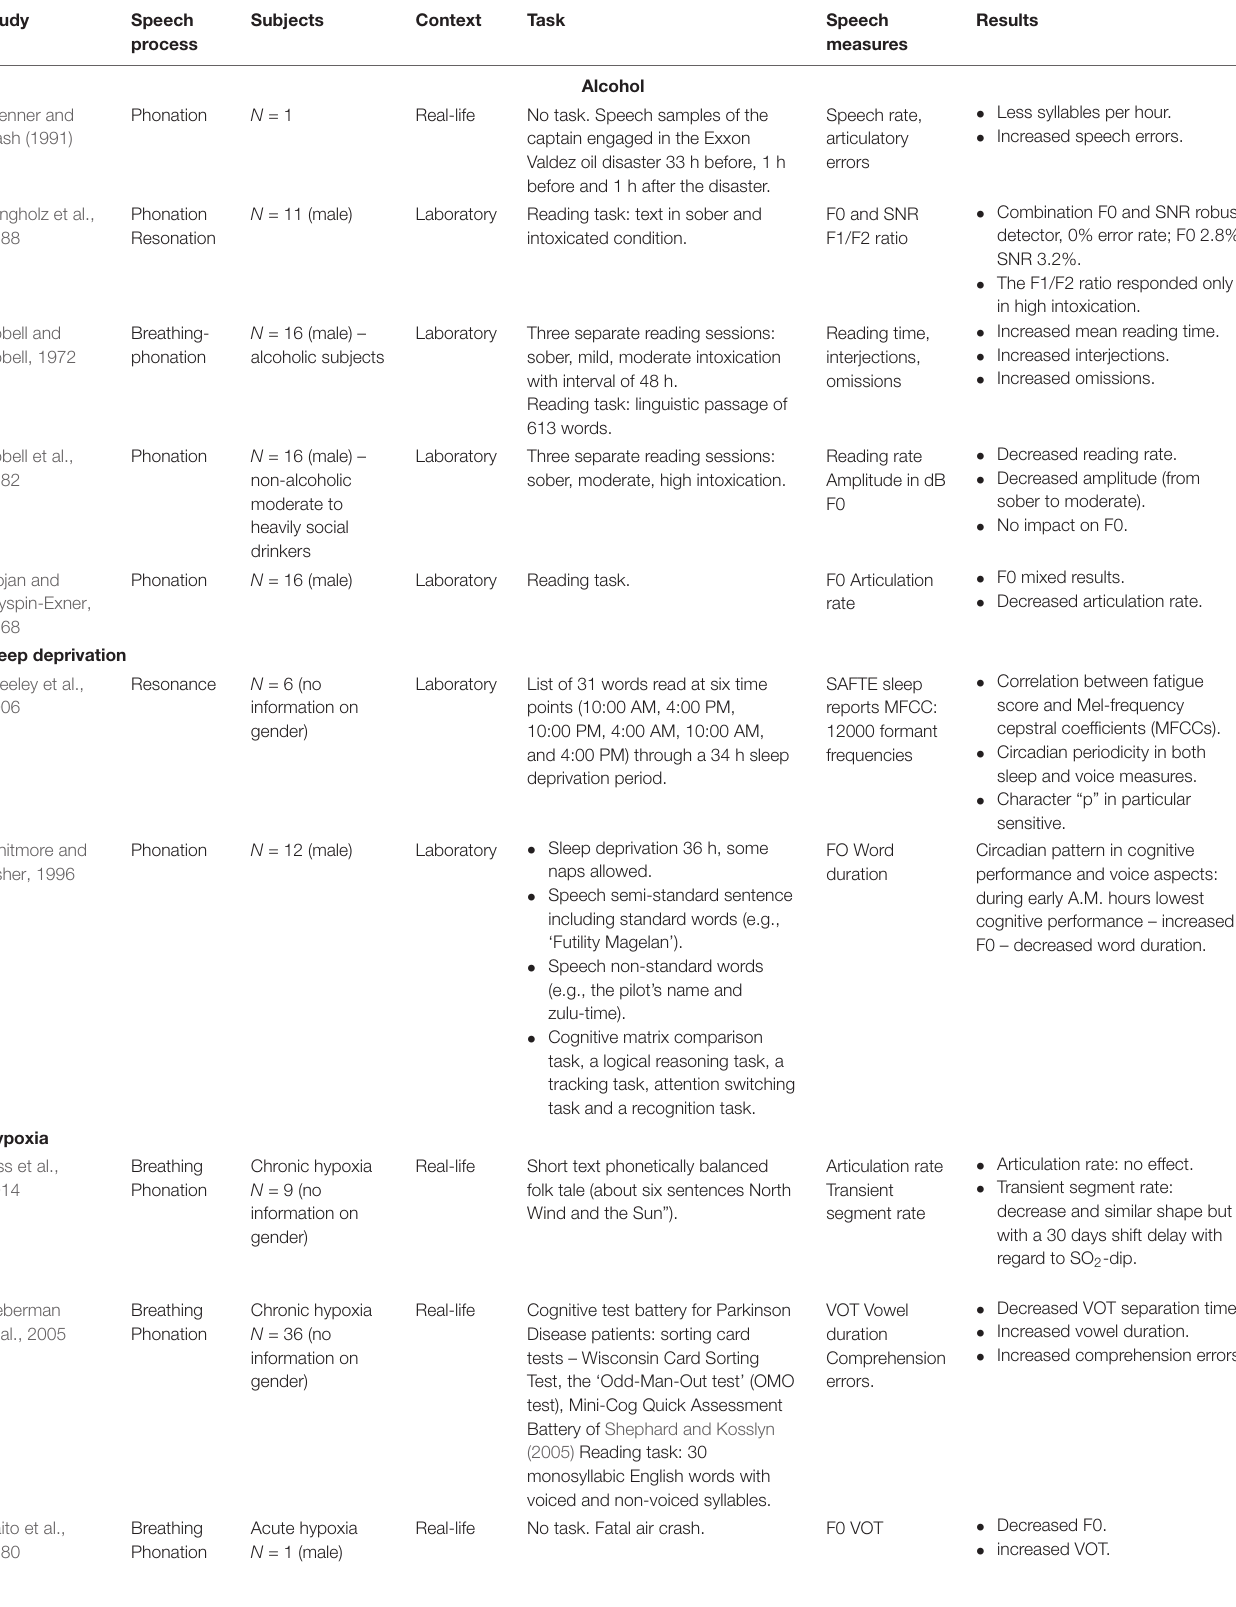
TABLE 4 | Deleterious impacts on human performance: studies on the impact of alcohol, sleep deprivation and hypoxia on voice and speech